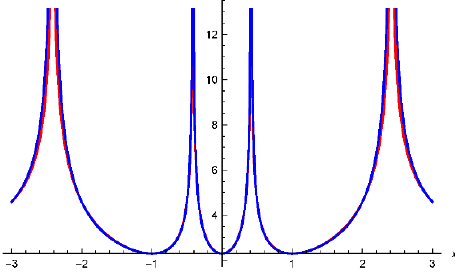
Figure 14 . The function c 1 K ( x )+ c 2 for a four-pole background with p 1 = p 2 and q 1 = q 2 is ( p 1 q 1 ) 5 = 2 p plotted in red. The total junction tension T ( x ) = p 1 q 1 for the same background is plotted in blue. The only slight deviations between the two are near the poles, where divergences occur and the plots are not expected to be reliable